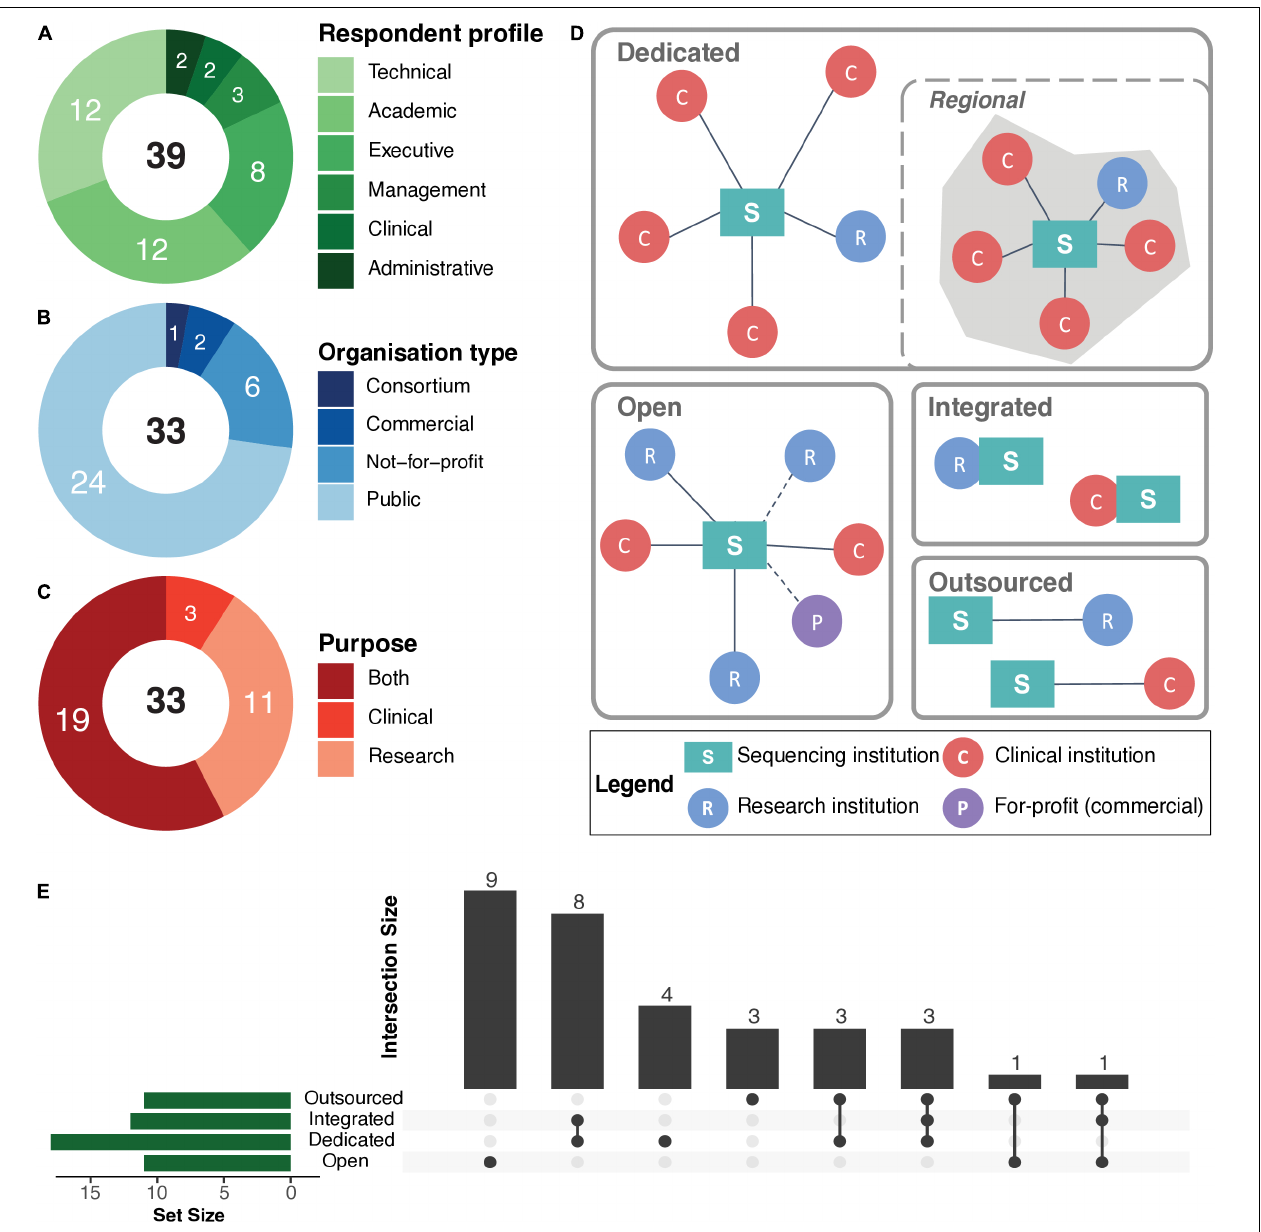
FIGURE 1 | Organisation structure and operations of sequencing institutions. (A) Summary of respondent profiles. (B) Summary of organisation types. (C) Use cases or purpose of human whole genome (WGS) or whole exome (WES) sequencing. In (A–C) , numbers in black text at the centre of the rings represent the total, while the numbers in white text on the rings represent the exact numbers for a particular category. (D) The various operational models practiced by the institutions participating in the interview study, in terms of human whole genome and exome sequencing: “Dedicated”—operate sequencing platforms in-house to serve an exclusive set of clinical and research clients. In certain cases, such institutions serve clients within a given region/locality (i.e., “Regional”). “Open”—a standard service-oriented institution with in-house sequencing platforms. “Integrated”—institutions/departments with in-house sequencing platforms that are embedded within a research and/or clinical unit. “Outsourced”—institutions that perform sequencing with external providers. (E) UpSet plot (Conway et al., 2017) represents the operational models and corresponding number of sequencing institutions that utilise those models for WGS/WES. The horizontal green bars represent the total number of a given operational model. The bottom panel represents specific combinations (or intersections) of operational models. The vertical bars represent the number of sequencing institutions using those combinations of operational models. Detailed information available in Supplementary File 2: Table S2